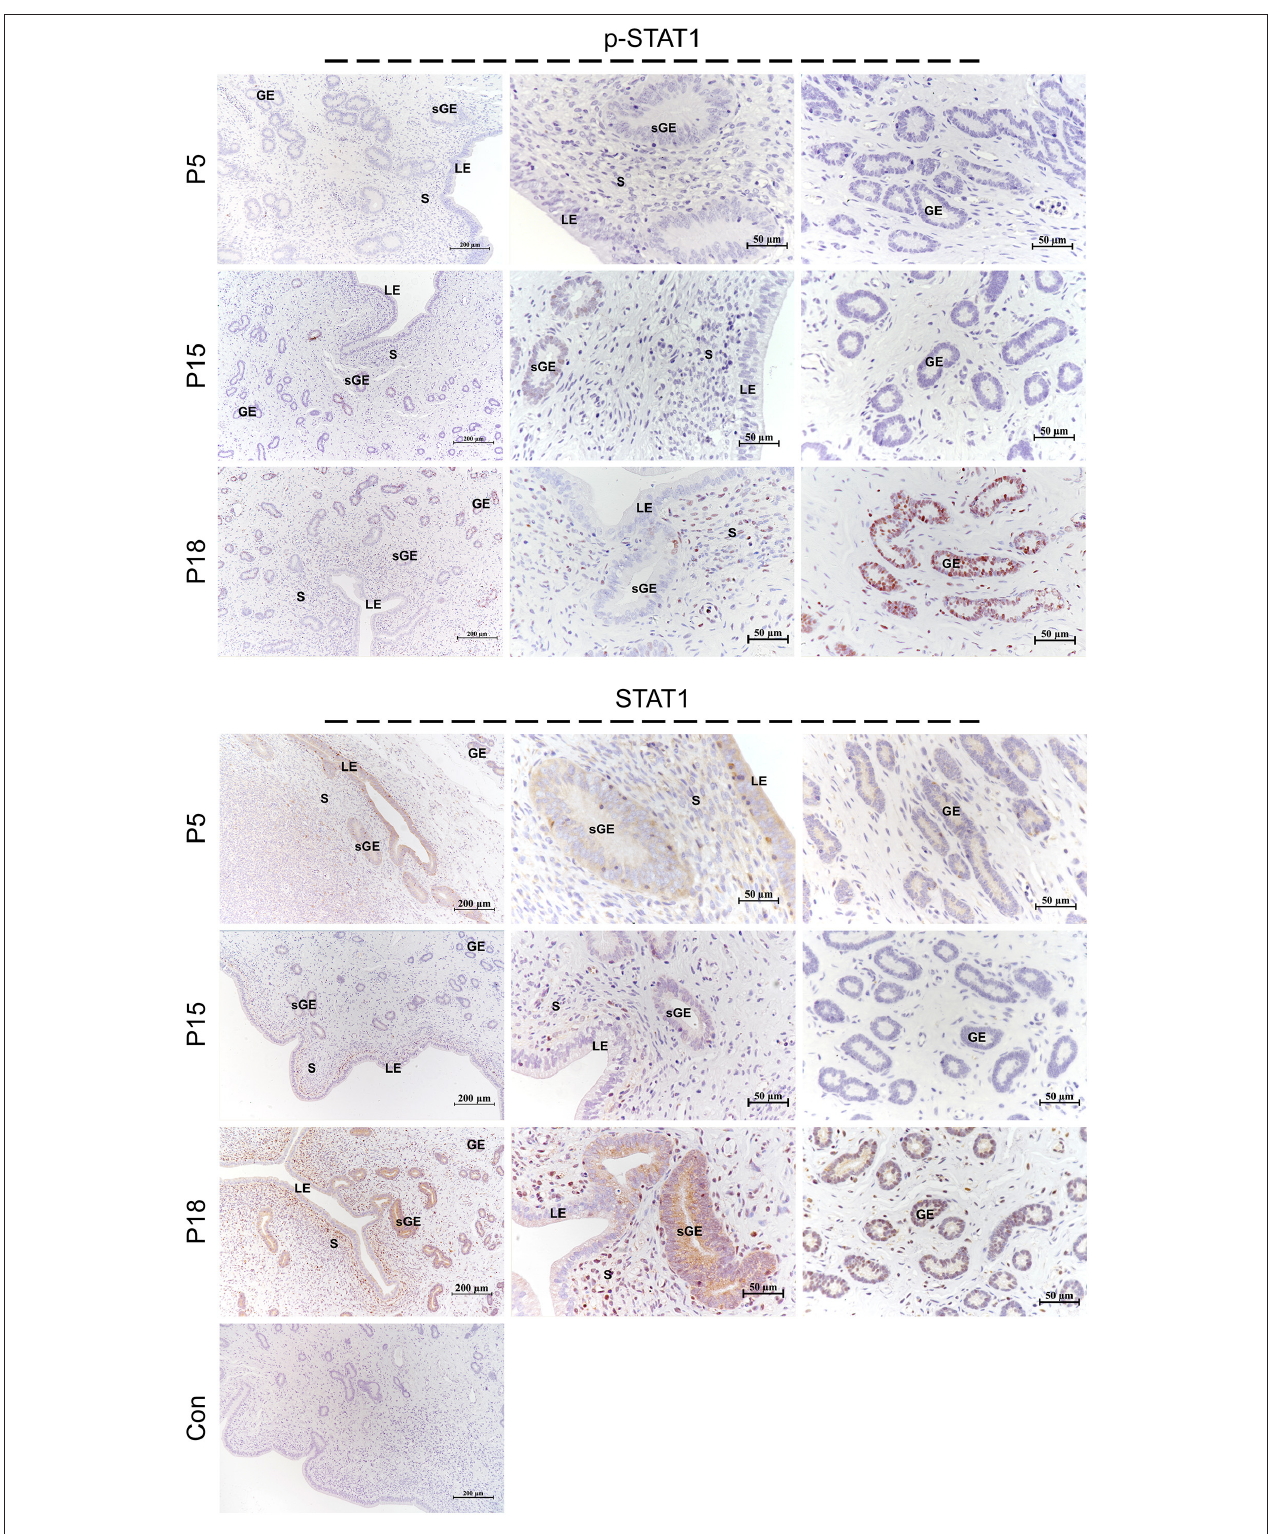
FIGURE 6 | Immunolocalization of p-STAT1 and STAT1 in goat uterus during early pregnancy. For Control, preimmune serum was substituted for the primary antibody. LE, luminal epithelium; GE, glandular epithelium; sGE, superficial glandular epithelium; S, stroma.